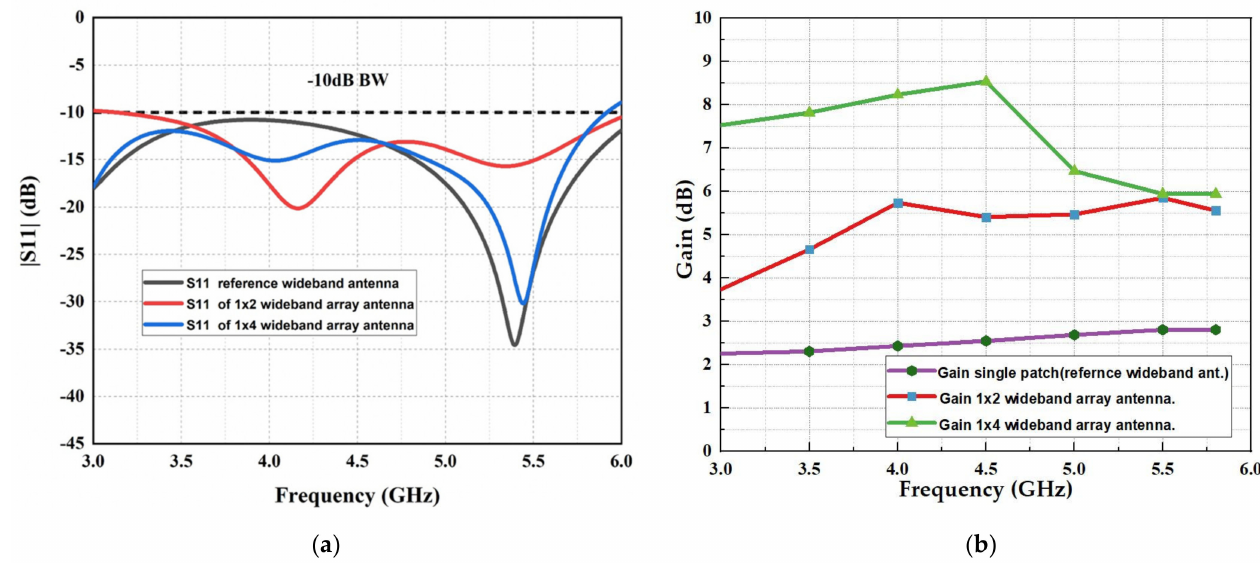
Figure 2. Simulated results of wideband microstrip array antenna development: ( a ) reflection coefficient (S11), ( b ) realized